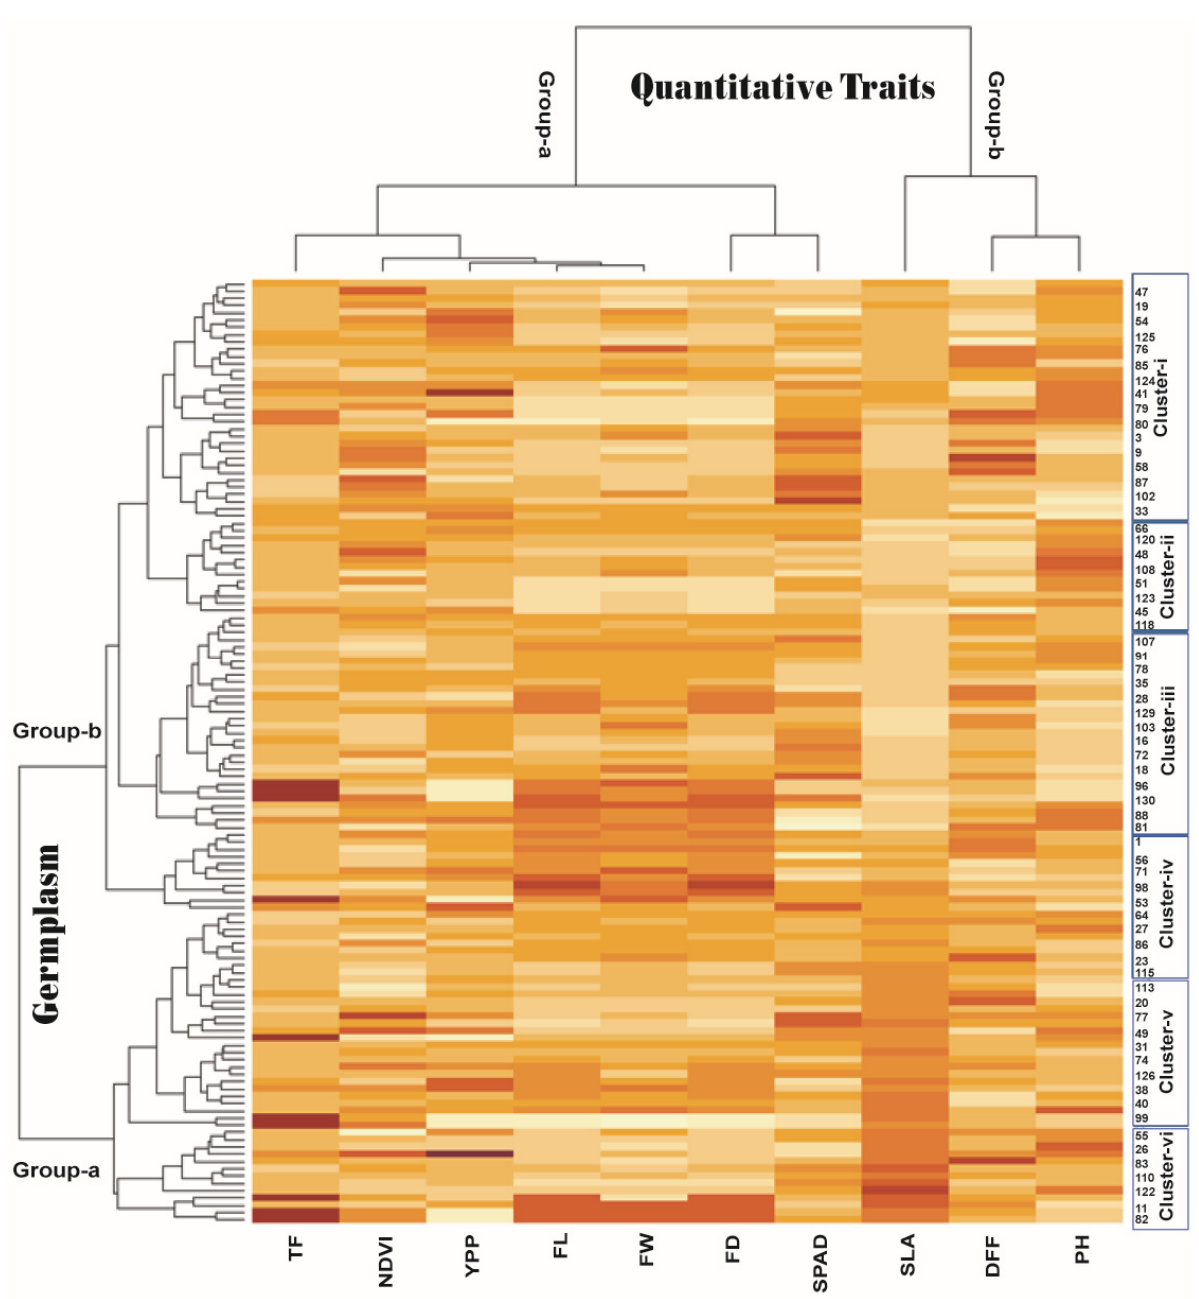
Figure 5. Heatmap showing the clustering pattern of 130 eggplant genotypes with 10 morpho-physiological traits. Heat map displaying the relationship matrix among Eggplant genotypes. The red diagonal represents a perfect relationship of each accession with itself. The symmetric off-diagonal elements represent the relationship measures for pairs of genotypes. The white of warmer colors on the diagonal show clusters of closely related genotypes. DFF = Days to first flowering (day), FD = Fruit diameter (cm), FL = Fruit length (cm), FW = Fruit weight (g), YPP = Yield plant − 1 (kg), NDVI = Normalized difference vegetation index, PH = Plant height (cm), SLA = Single leaf area (cm 2 ), SPAD = Soil plant analyses development, TF = Total number of